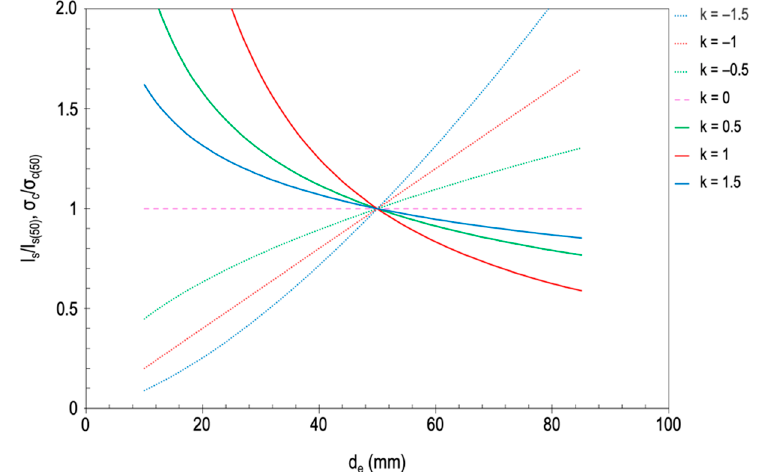
Figure 1. Effect of the k value ( k 1 and k 2 for Equations (26) and (27), respectively) on the scale effect of rock strength. By definition, k > 0 [41], but negative k values have been added to represent possible ascending models (adapted from Wang et al. [26]).